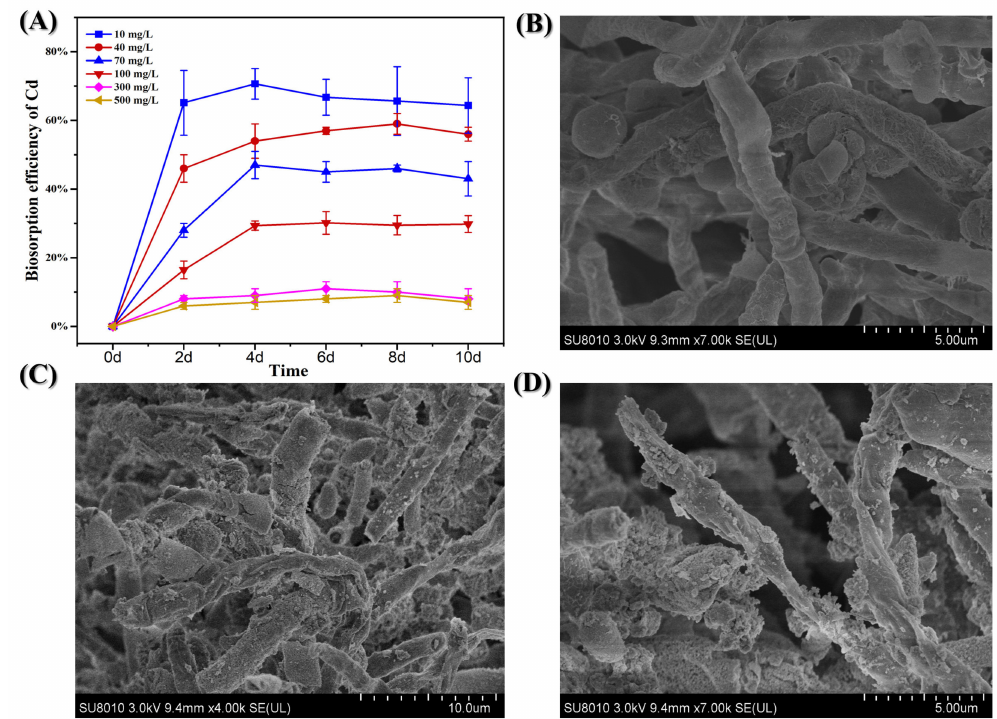
Figure 2. ( A ) The Cd biosorption efficiency of P. lilacinum N1 at initial Cd concentrations of 10 mg/L and 100 mg/L; ( B ) SEM image of normal mycelia. SEM image of mycelia grown in the NB liquid medium supplemented with 9000 mg/L of Cd (II) with the resolution of 10 µ m ( C ) and 5 µ m ( D